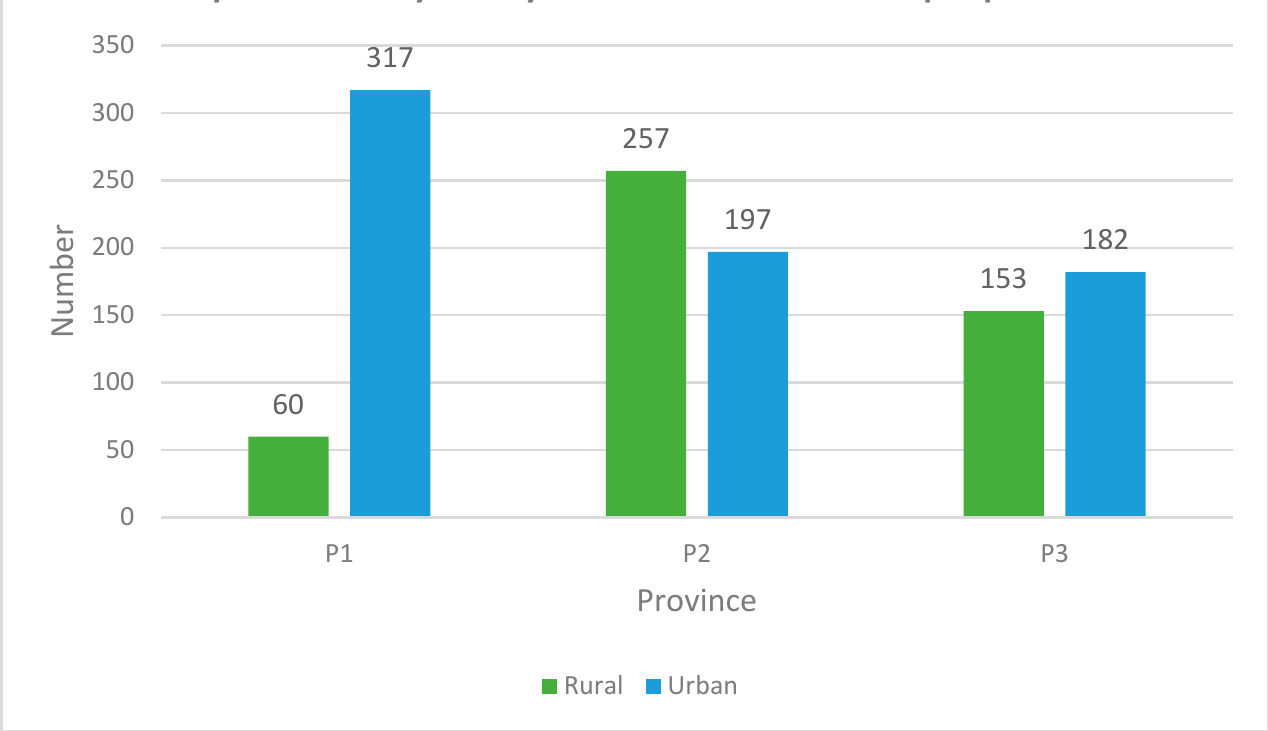
Figure 8. Distribution of profession types per rural/urban area. Legend: P—province.